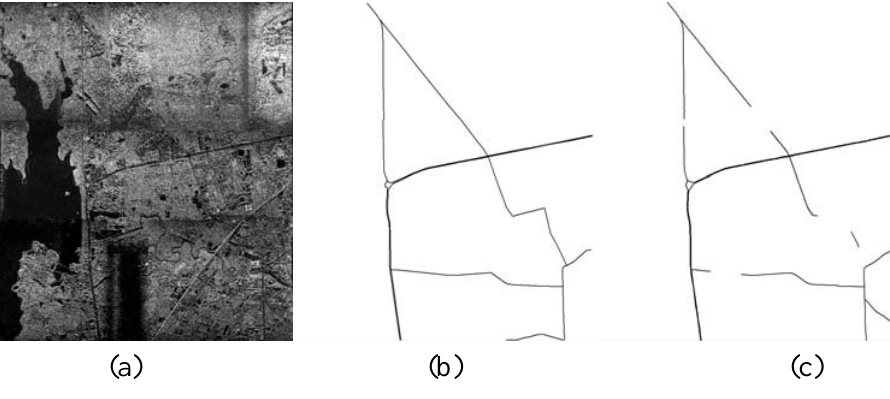
Figure 6. Road network extraction from an airborne SAR image. (a) Raw SAR image with 0.3 m pixel-1 resolution and 23,999 pixels by 20,172 pixels image size; (b) the reference road network plotted; (c) The extracted vector road network by PATS.